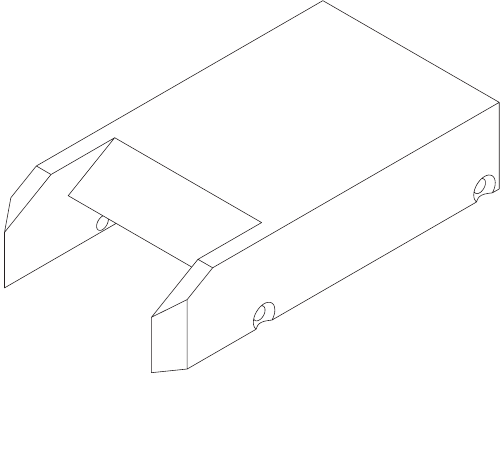
Figure 4. Single-piece cowl components made entirely from quartz to allow for an unobstructed view of the isolator